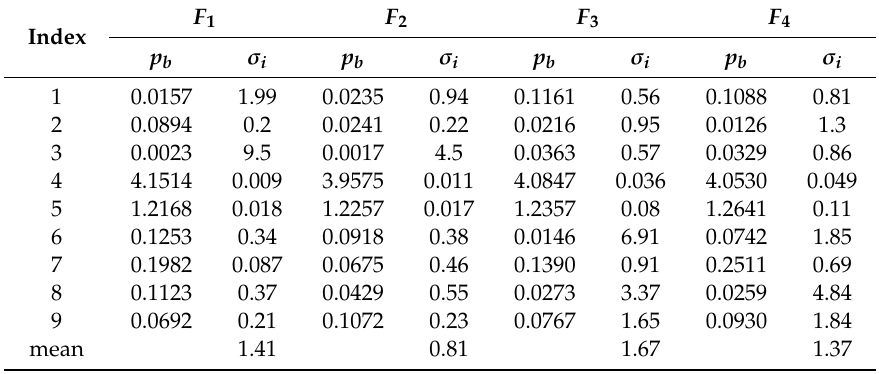
Table 4. Identified dynamic parameters and their respective deviations of the 2-DOF robot.